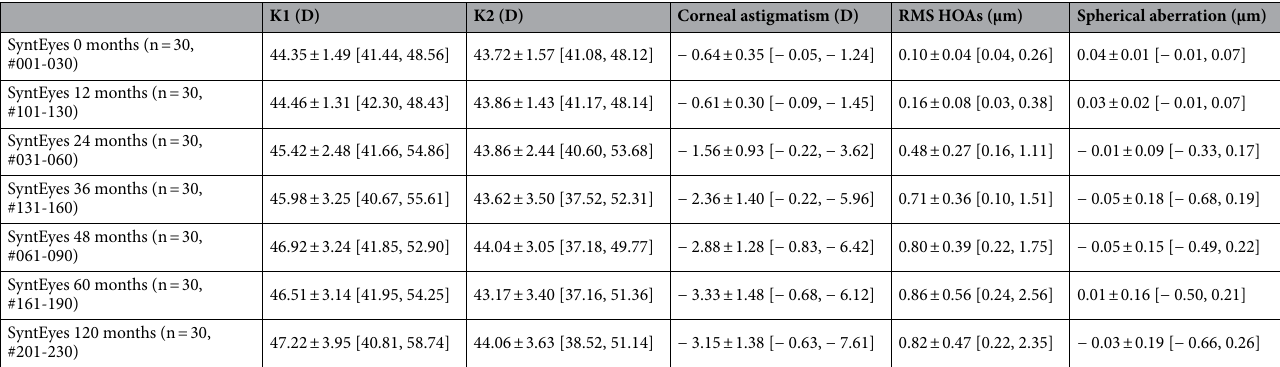
Table 1. Descriptive corneal parameters: corneal power (K1 and K2 in D), corneal astigmatism (D), the root- mean square (RMS) of corneal high-order aberrations (HOAs) and the spherical aberration of the cornea (in microns, μm; 4-mm pupil diameter). Average ± standard deviation [minimum, maximum]. # represents the eye number from the previous published SyntEyes KTC models 28